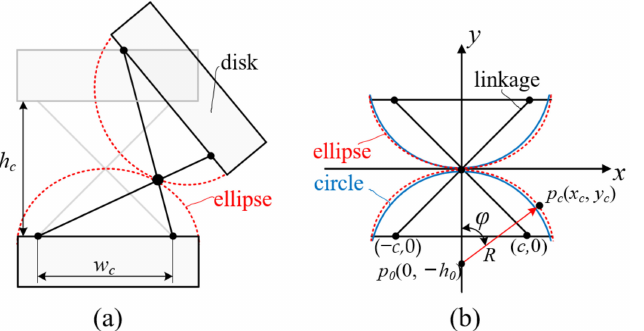
Figure 1. Sketch of anti-parallelogram mechanism. ( a ) The anti-parallelogram joint sketch. ( b ) The initial configuration of the anti-parallelogram